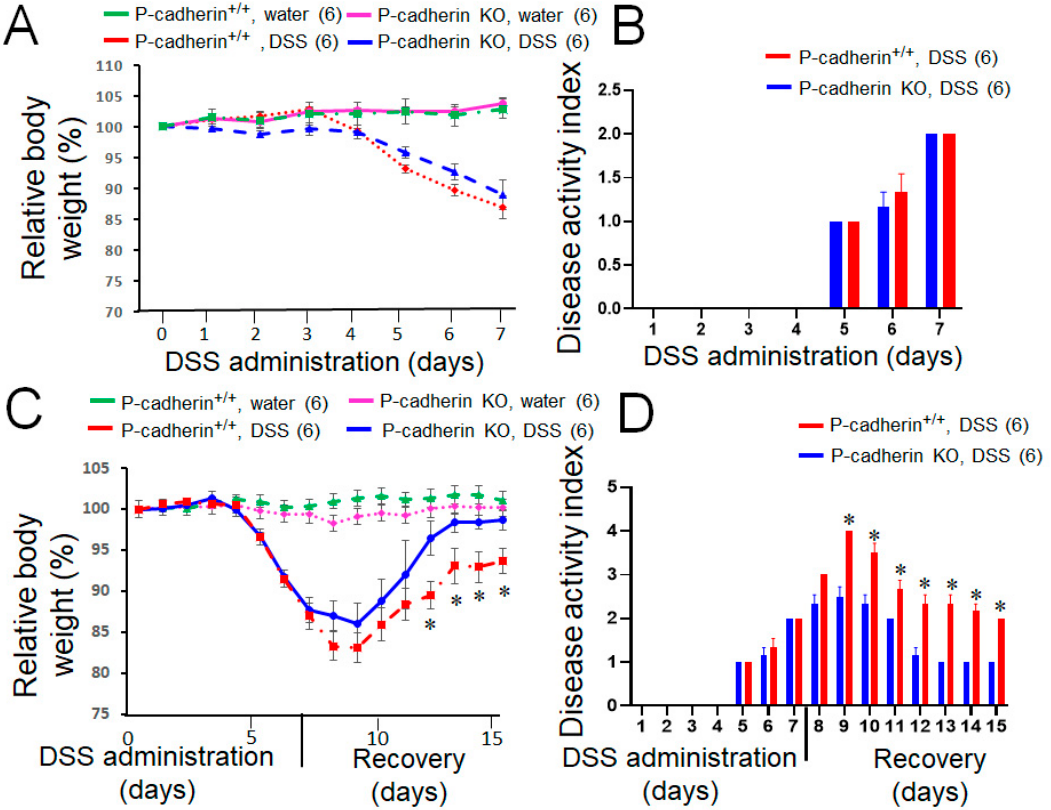
Figure 2. Loss of P-cadherin does not affect development of acute DSS colitis but promotes post-colitis recovery. P-cadherin knockout (KO) mice and their control littermates (+/+) were subjected to acute DSS colitis (3% DSS in drinking water) for 7 days ( A , B ) or exposed to 3% DSS for 7 days and allowed to recover after DSS withdrawal ( C , D ). Body weight ( A , C ), and disease activity index ( B , D ) were recorded daily. Mean ± SE. Number of animals in each group is shown in parentheses. * p < 0.05. Data are representative of two independent experiments.